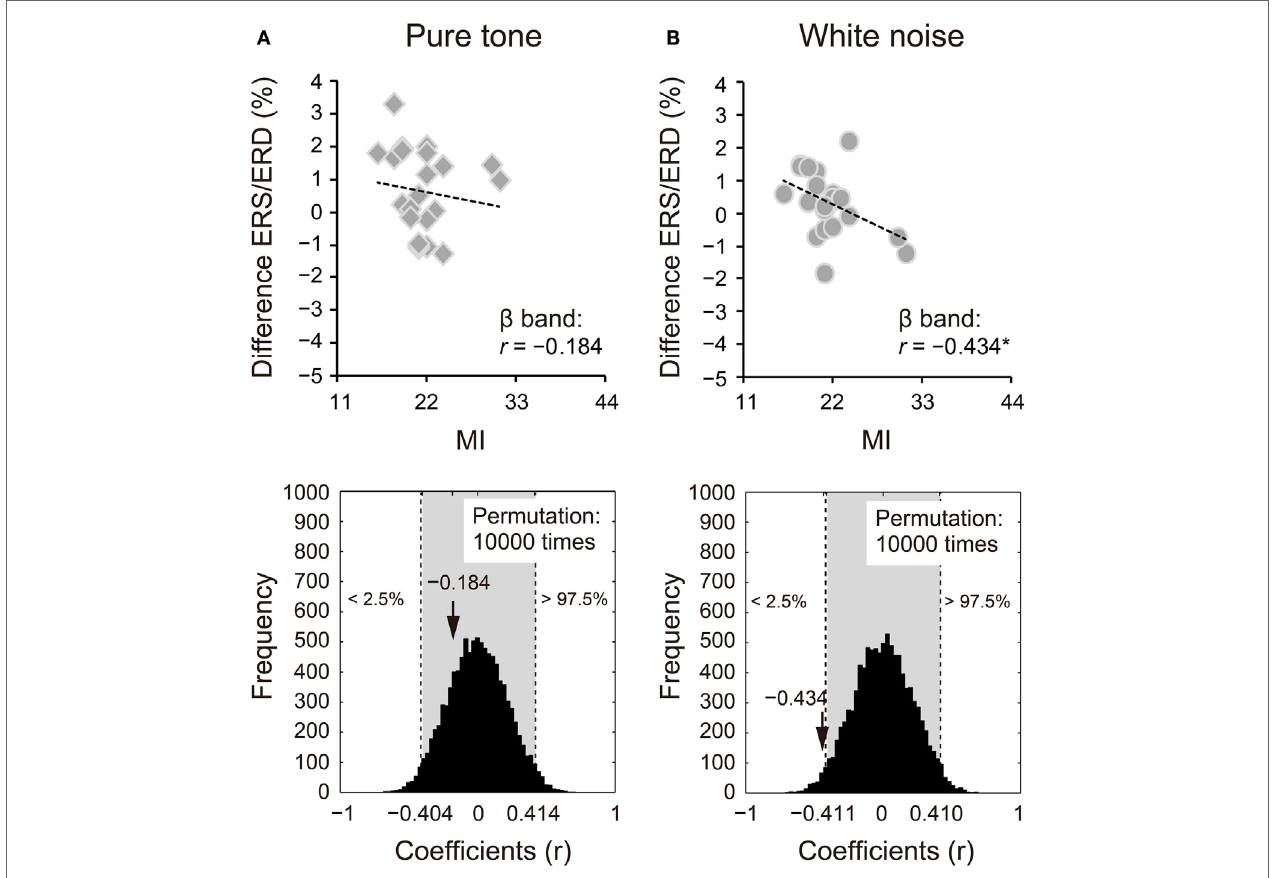
FigUre 6 | Power changes in β bands (12–30 hz) of the second sounds for (a) pure tone and (B) white noise correlated with self-reported motor impulsivity (Mi) . Power changes of β bands were calculated by subtraction of event-related desynchronization (ERD) scores for the first stimuli from those for the second stimuli. White noise showed a negative correlation between power change and self-reported MI, indicating that higher MI scores are associated with greater (more negative) ERD for S2. The actual coefficient ( r = − 0.434) is outside the 95% confident interval (light gray area) of the permutation distribution [lower diagram in (B)